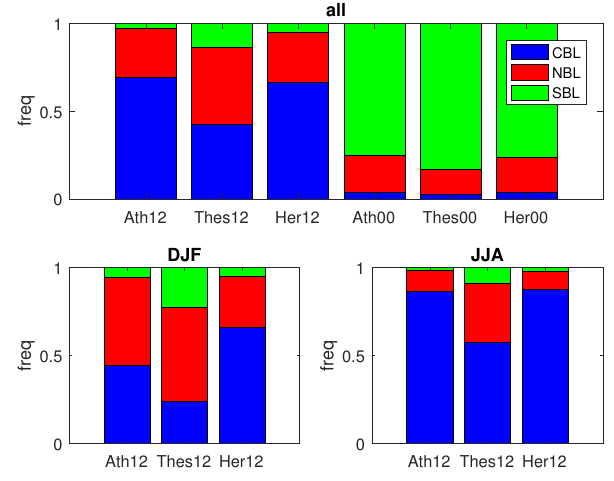
Figure 4. Upper panel: Frequency of the three types of boundary layers for all seasons. Lower panels: Frequency of the three types of daytime boundary layers for the winter months (lower left) and the summer months (lower